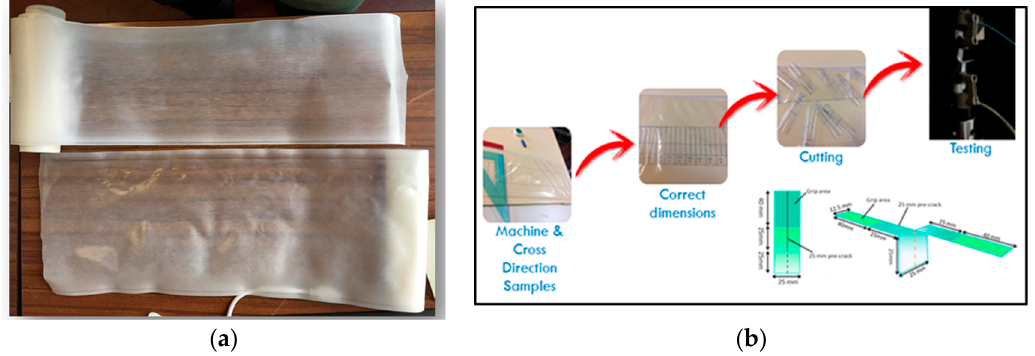
Figure 9. ( a ) F3 semitransparent films obtained by flat die extrusion; ( b ) methodology adopted for trouser tear tests.